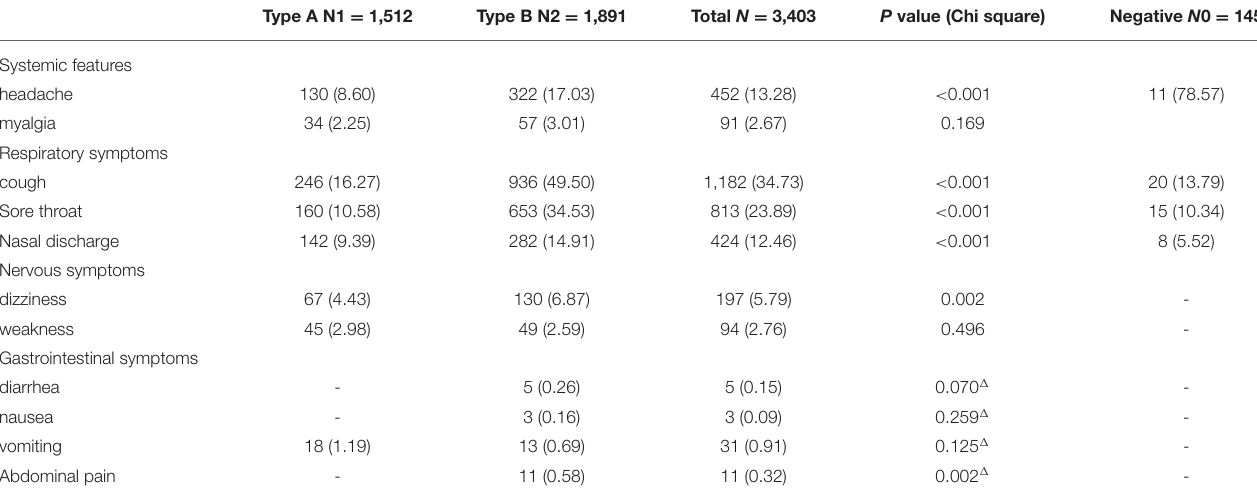
TABLE 2 | Comparison of symptoms between influenza A and B cases.